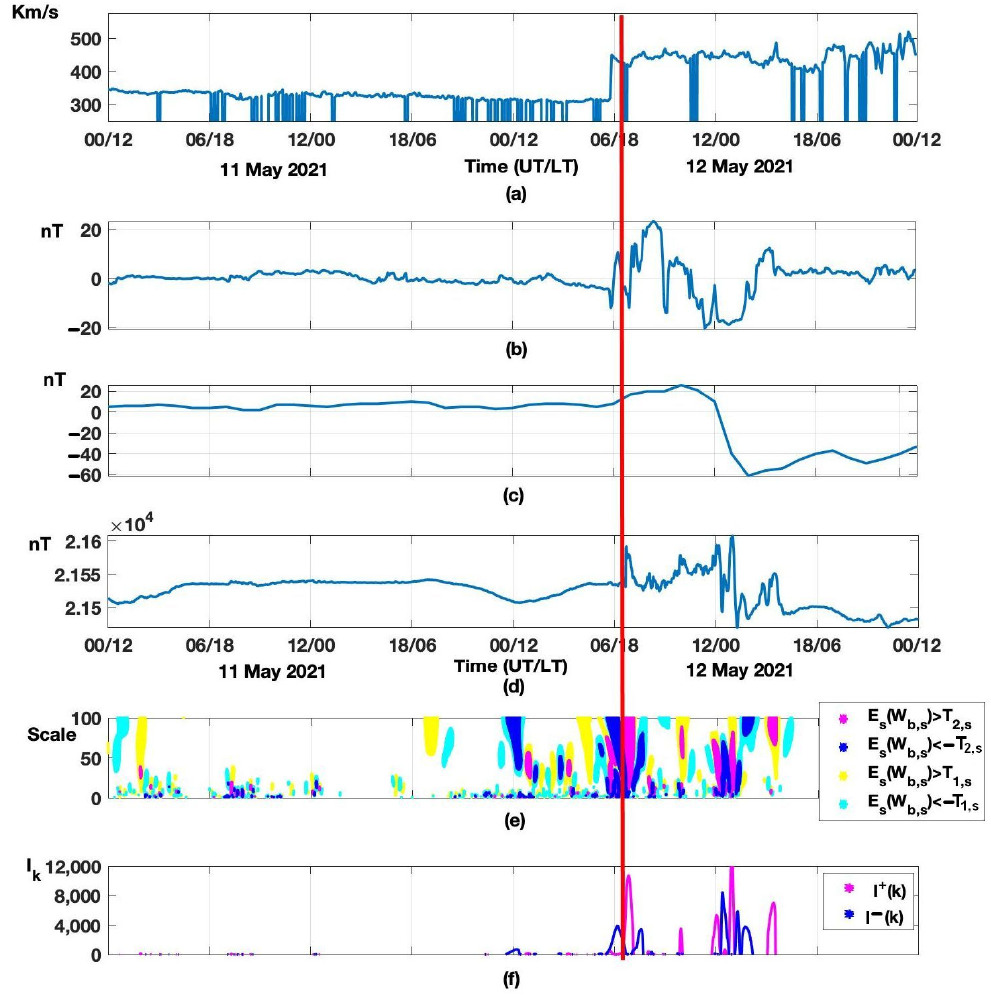
Figure 10. Results of sequential processing of geomagnetic data for the period 11–12 May 2021, before the storm